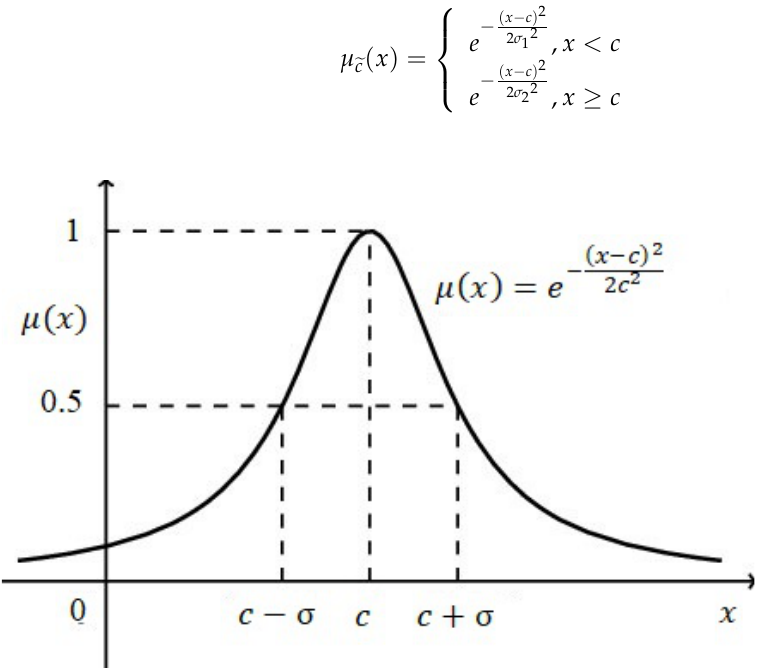
Figure 1. Gaussian Fuzzy